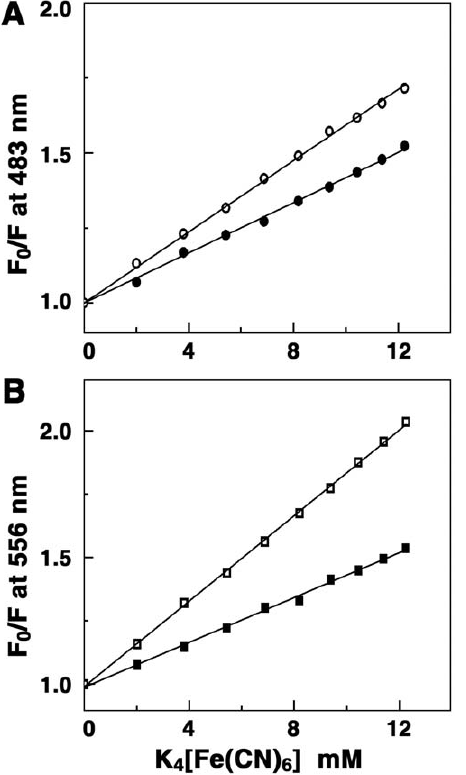
Figure 4. Stern-Volmer plots for the quenching of the fluorescence of drugs-tRNA complex by K 4 [Fe(CN) 6 ]. (A) ADG and (B) DAU. Symbols are in absence ( # ) ADG, ( % ) DAU and, in presence ( N ) ADG and ( & ) DAU of tRNA.